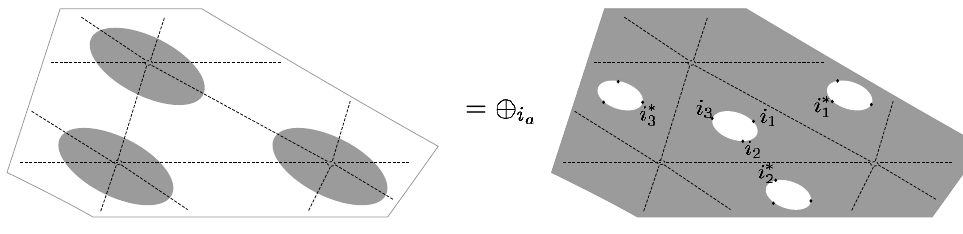
Figure 37 . The Hilbert space associated to a surface (cid:6) 0 with a regular arrangement of holes (left) can be identi(cid:12)ed with a direct sum of tensor product of Hilbert spaces associated to a collection of three-punctured disks. For clarity, we denote the boundary line defects L i \ i a " and \ i (cid:3) ". Disks are in correspondence to faces of the triangulation. Pairs of dual defects are a in correspondences to the edges of the